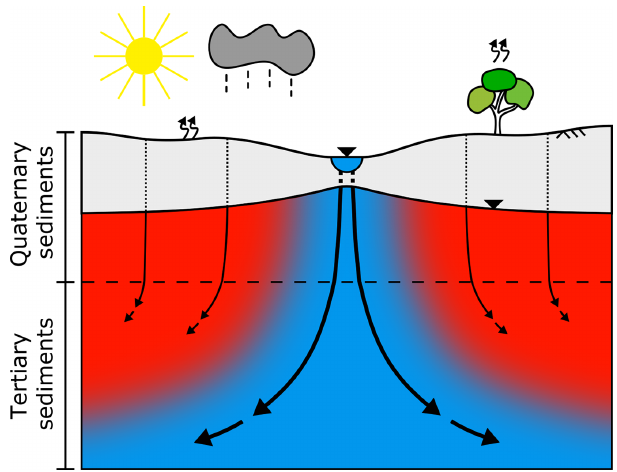
Figure 14. Conceptual model of the recharge mechanisms for the aquifers of the AP basin, as seen in a cross section perpendicular to a stream in the mountain-front zone, and how these mechanisms can explain the observed groundwater salinity. Blue to red colours indicate relatively low to high